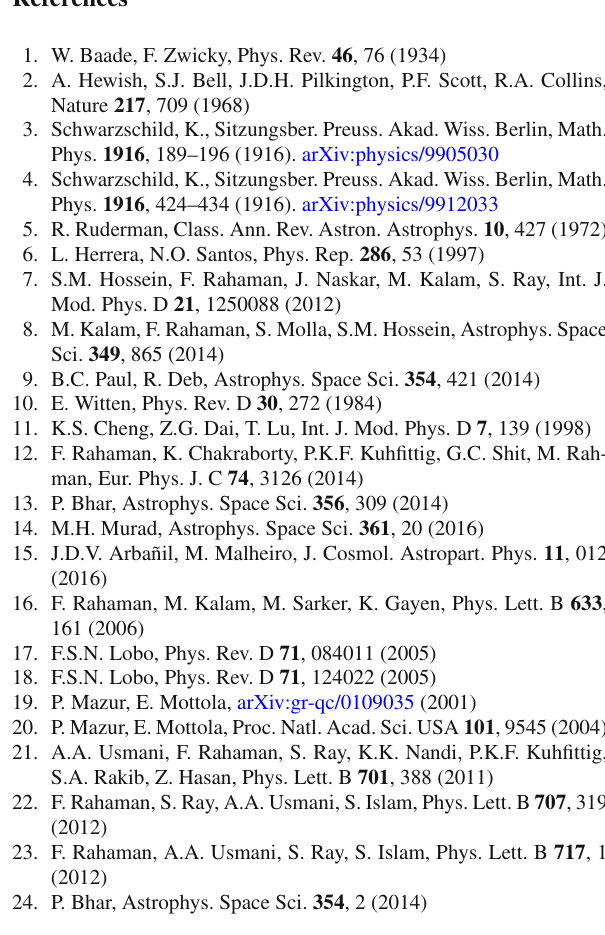
Fig. 20 Variations of z s versus r (km) with the numerical values of A , B and C from Tables 2, 3 and 4 respectively v 2 > v 2 − v 2 | ≤ 1 and (cid:8) > 4 / 3 for all of three , | v 2 sr st st sr